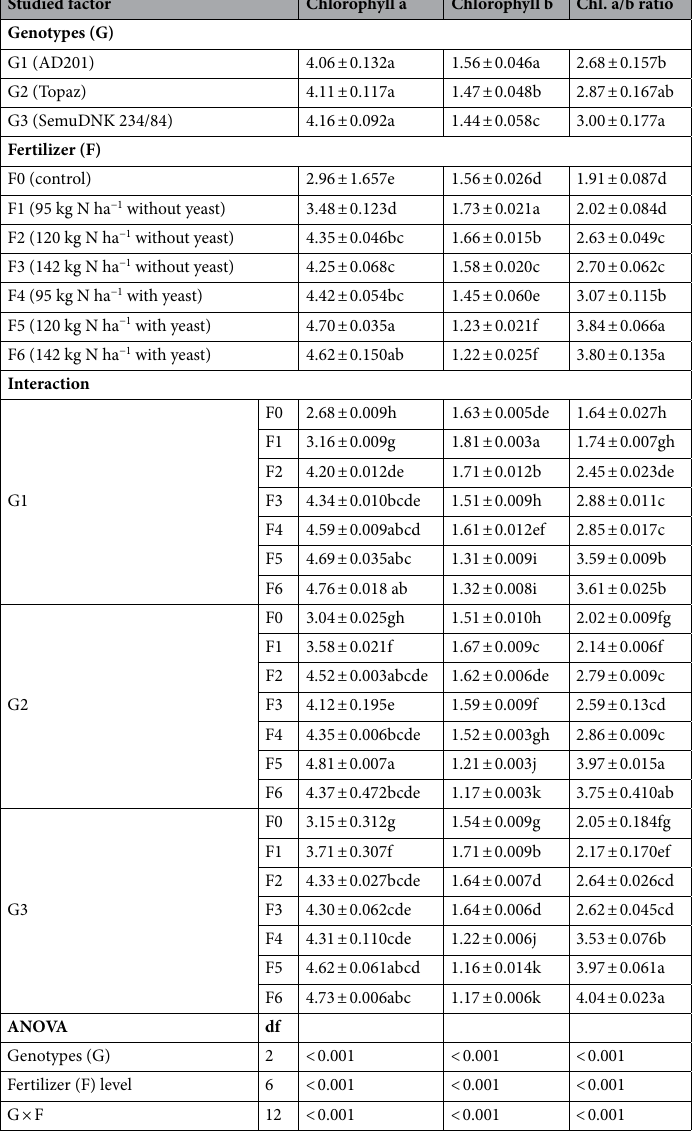
Table 1. Photosynthetic pigments for the three Canola genotypes under different N applications without and with yeast